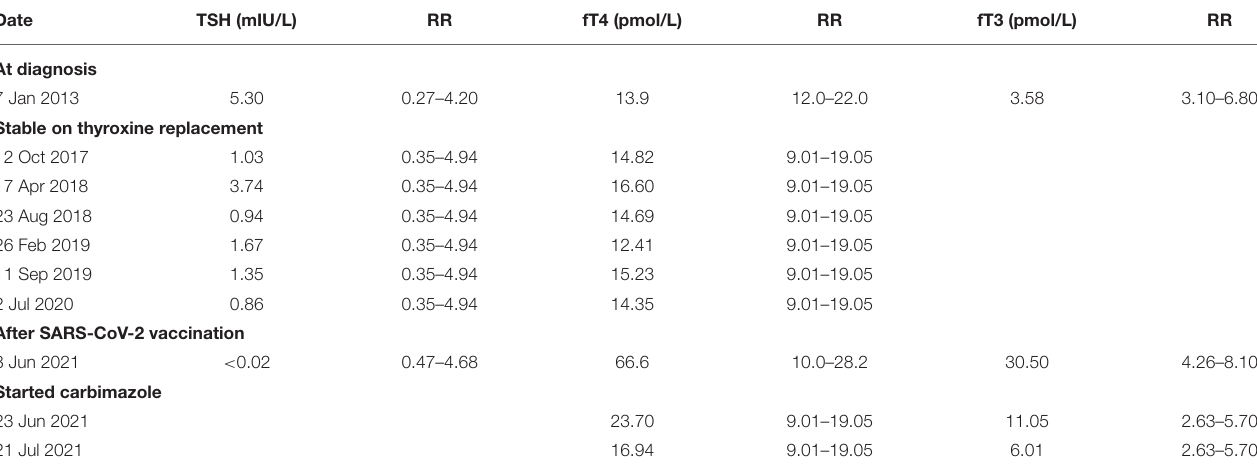
TABLE 1 | Serial thyroid function tests and anti-thyroid antibody titers in our reported